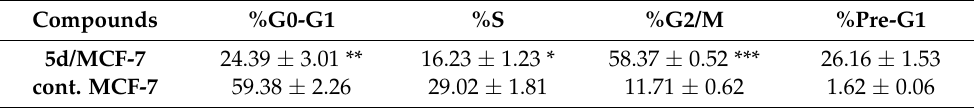
Table 3. Cell cycle distribution of compound 5d in MCF-7 cell line.